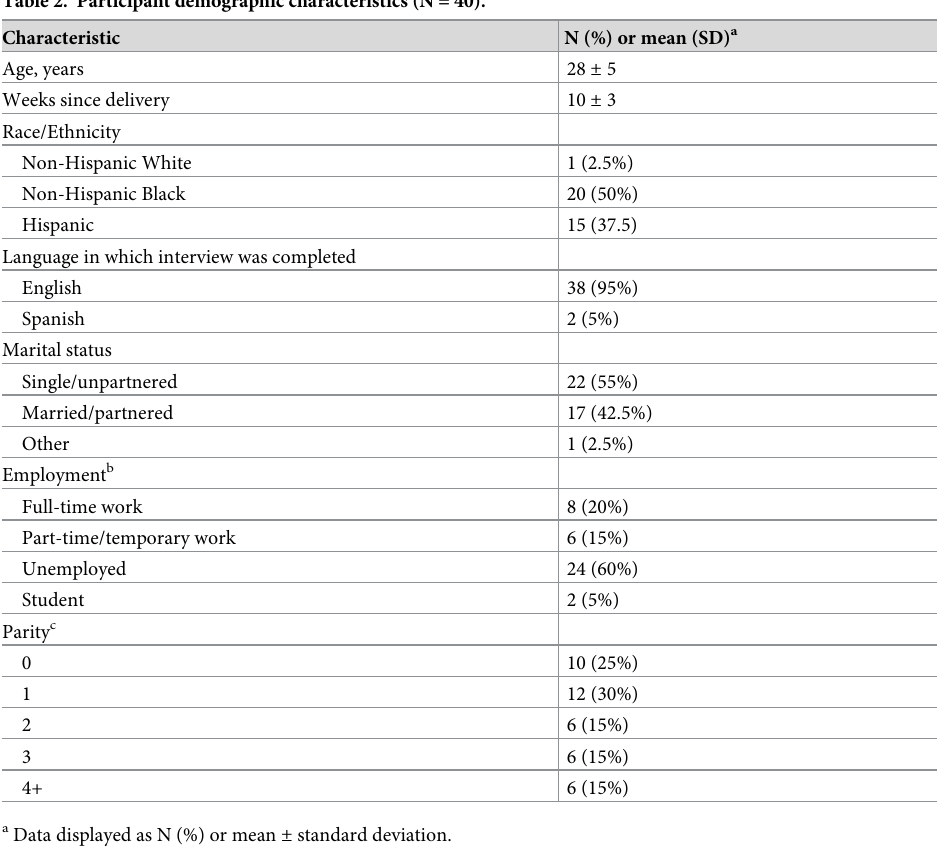
a Data displayed as N (%) or mean ± standard deviation.